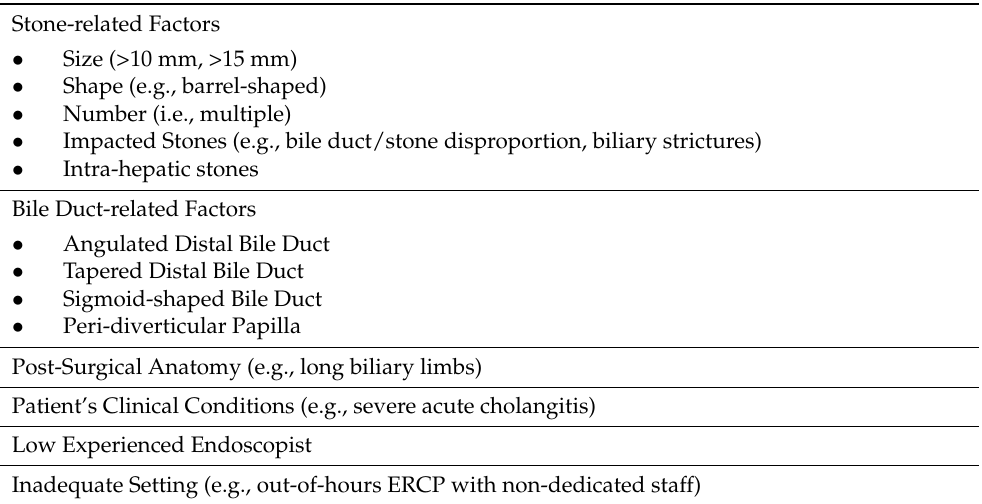
Figure 1. Cases of difficult biliary stones not amenable to conventional ERCP treatment. ( A , B ) Mag- netic Resonance Images showing complex bile duct stones with large signal defects extending to the hilum and intrahepatics; ( C ) cholangiogram showing a very large common bile duct stone. All cases were successfully managed with single-operator cholangioscopy-assisted electrohydraulic lithotripsy. Table 1. Factors possibly associated with difficult or incomplete stone